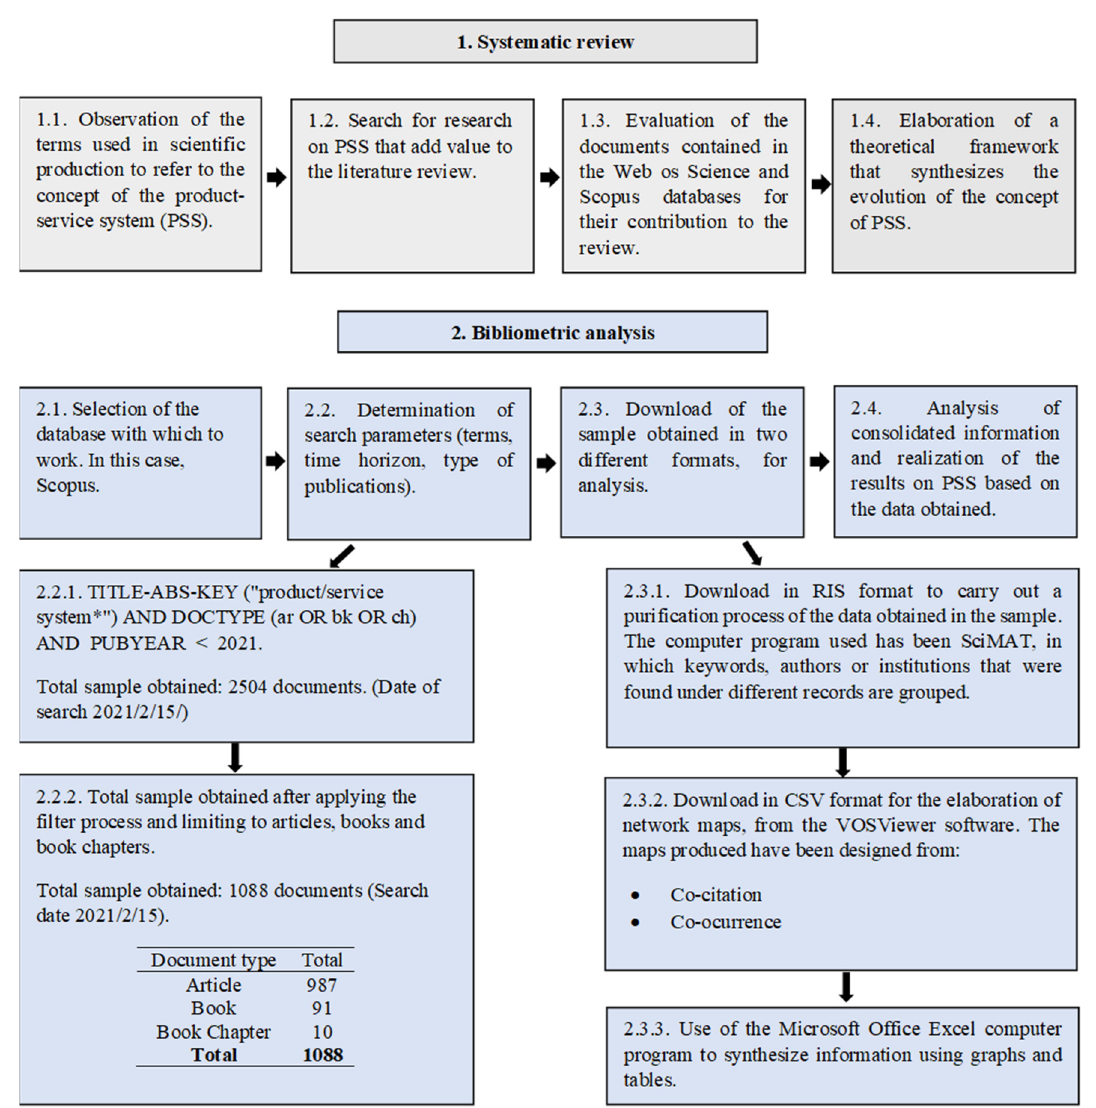
Figure 1. Explanation of the methodology used.